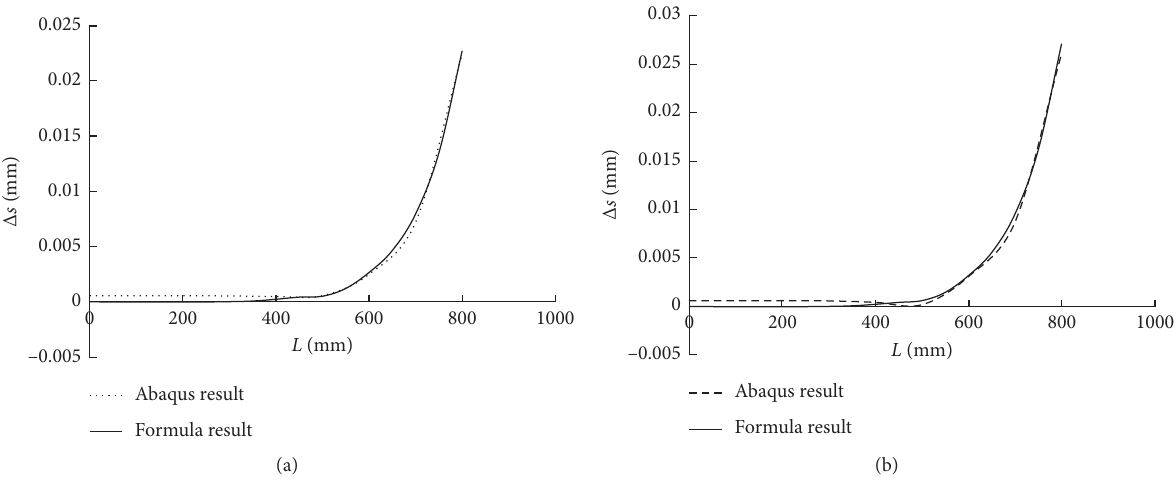
Figure 6: The comparison between numerical results and calculation results. (a) Temperature of 20 ° C. (b) Temperature of 25 °